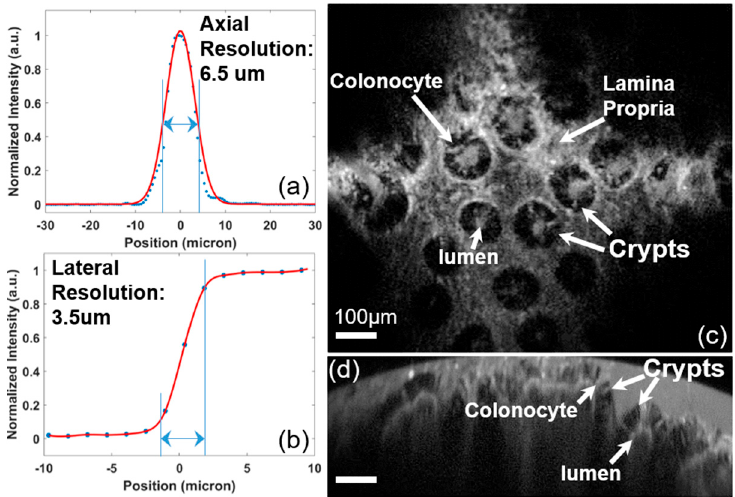
Figure 10. Fluorescence imaging results of the NIR fluorescence intraoperative confocal microscope. ( a ) Lateral and ( b ) axial resolution at the wavelength of 785 nm (focus at 150 µm out of the SIL) by measuring the FWHM in the reflective mode; ex vivo fluorescence images of human colon tissue specimens demonstrated “histology-like” imaging with a large field-of-view (up to 1000 µm), in both the ( c ) en face horizontal cross-sectional image at the 150-µm depth and ( d ) vertical cross-sectional image; crypts, colonocytes, and lumen have been visualized with cellular resolutions, scale bar: 100 µm.